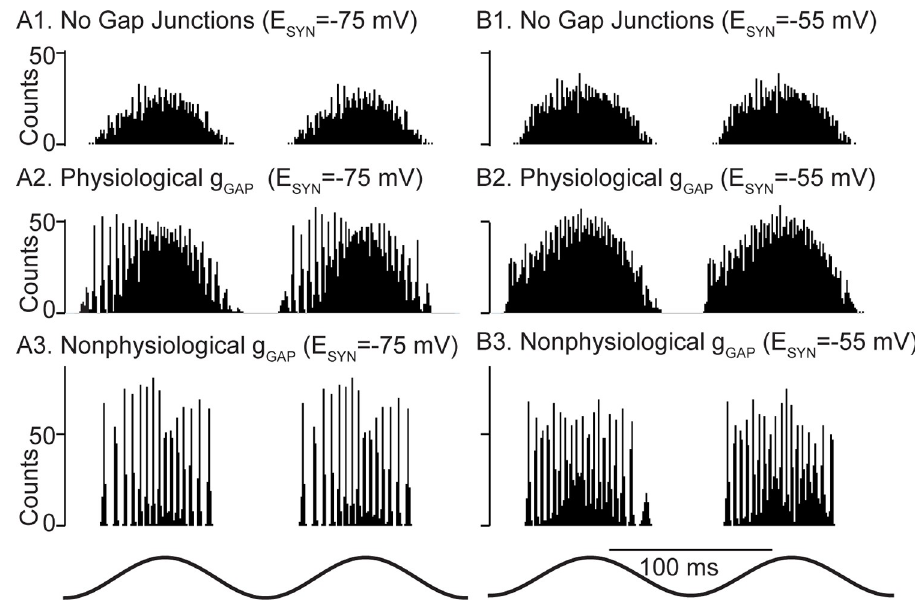
Fig 6. Gap junction connectivity is required for theta nested fast oscillations in heterogeneous networks. Representative spike histograms as a function of time. A . Networks with hyperpolarizing inhibition. B. Networks with shunting inhibition. A1. and B1. Fully heterogeneous networks (both intrinsic and synaptic heterogeneity) with no gap junctions. A2 and B2 . Heterogeneous networks with gap junctions calibrated according to Fig 2B and the text accompanying this figure. A3 and B3 . Heterogeneous networks with 2 nS gap junctions with no compensatory reduction in leakage